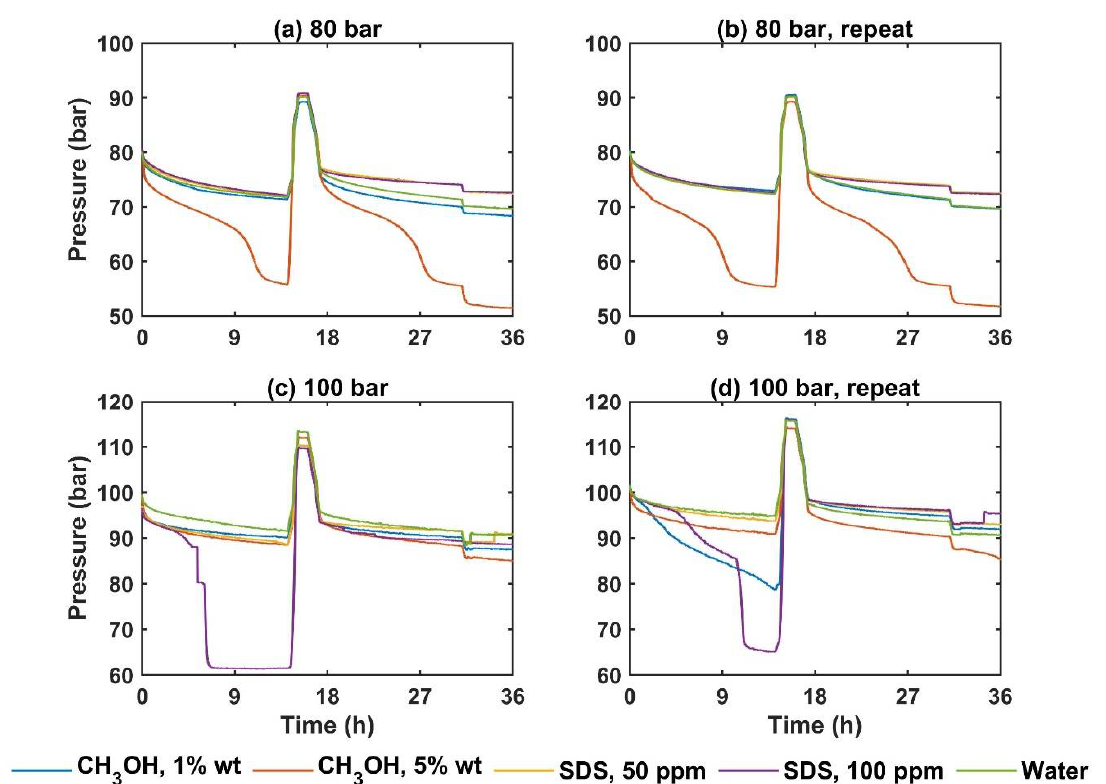
Figure 5. Pressure variation (fresh and memory run) during the isothermal scheme in the presence of MeOH (1 wt%, 5 wt%), SDS (50 ppm, 100 ppm), and pure water. p = 80 bar and 100 bar, T = 1 °C. ( a , b ) Pressure profile (fresh and memory) under 80 bar (2 trials) ( c , d ) Pressure profile (fresh and memory) under 100 bar (2 trials). Pressure increase above initial pressure is on account of temperature increased from 1 °C to 25 °C. (Starting pressure is pressure at 1 °C).